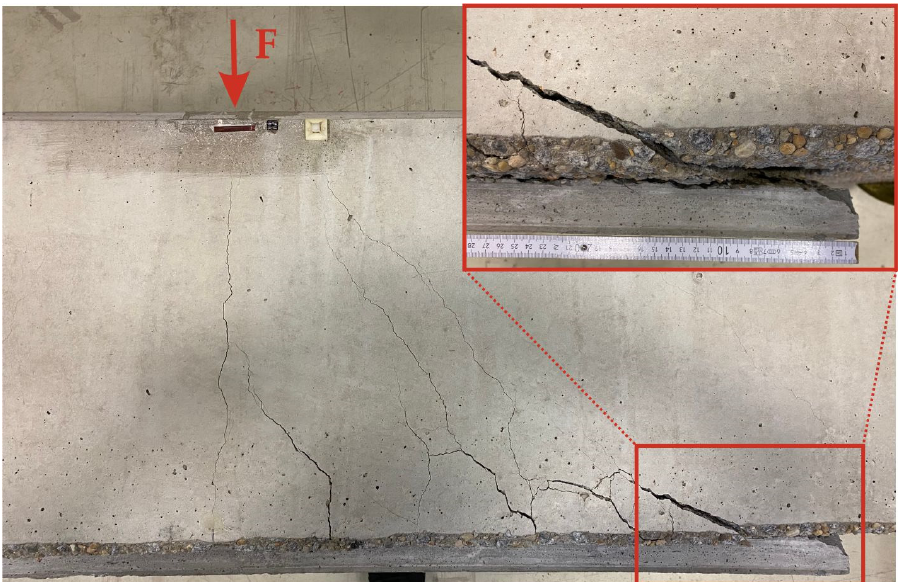
Figure 13. Concrete cover separation at the end of the strengthening layer with 6 layers of carbon reinforcement. (Photo: CARBOCON GMBH).